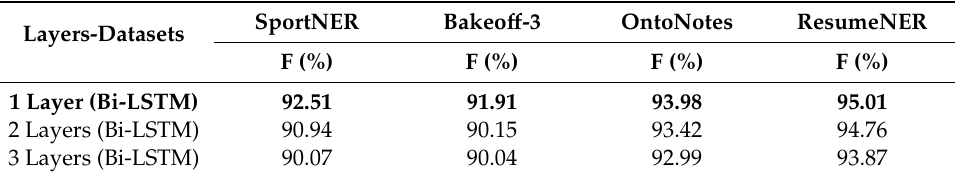
Table 9. The e ff ect of di ff erent bidirectional long-short-term memory (Bi-LSTM) layers on the model